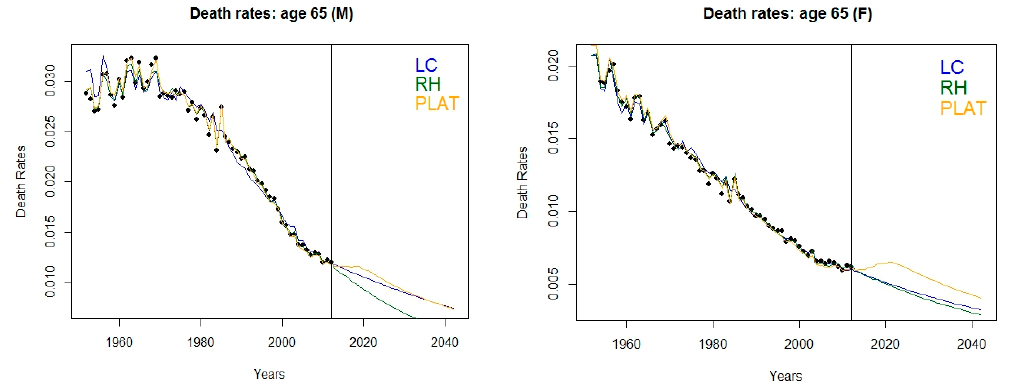
Figure 3. Observed and fitted death rates with forecasts 30 years onwards.